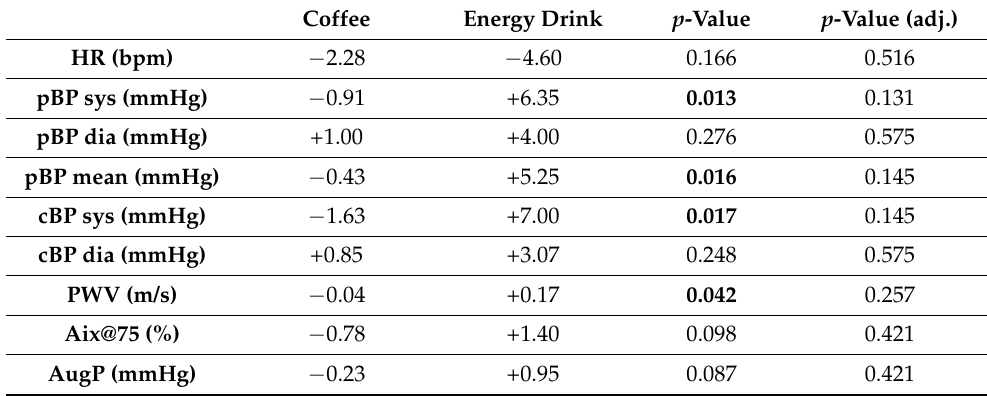
Table 3. Absolute changes of hemodynamic parameters after caffeine